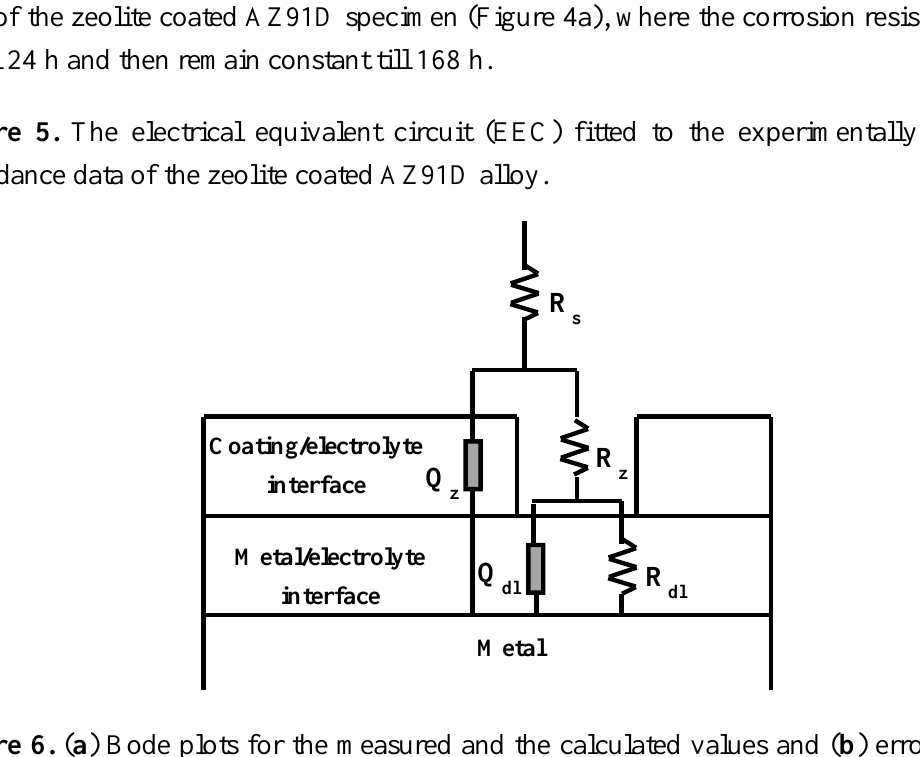
Figure 6. ( a ) Bode plots for the measured and the calculated values and ( b ) error plots of the zeolite coated AZ91D at 2 h of immersion in 0.1 M NaCl